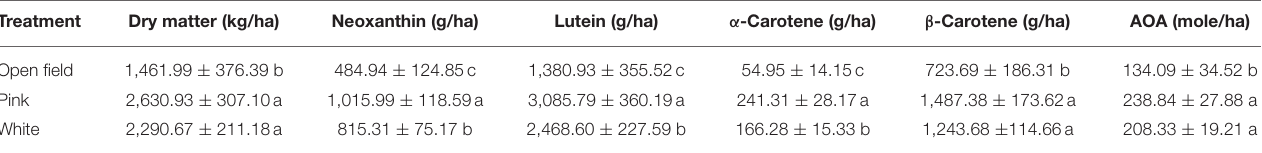
TABLE 8 | Dry matter content, carotenoids and anti-oxidant activity of red amaranth under colored poly-net house, white poly-net house, and open field conditions in Taiwan during 2020–2021.